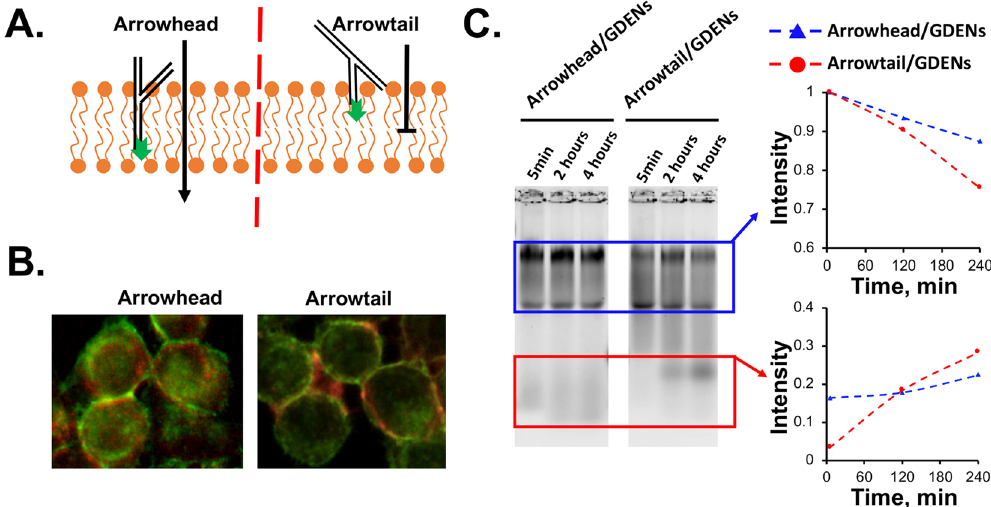
Figure 5. The interaction of arrowtail and arrowhead-displaying GDENs with cells. ( A ) Concept of ligand displaying by arrowtail and partially loading by arrowhead cause by different orientation. ( B ) Alexa 647 labeled arrowtail and arrowhead RNA nanoparticle (red) incubate with KB cell (green) and image by fluorescent microscopy as model to show surface displaying and loading. ( C ) Serum digestion assay indicate partially loaded arrowhead RNA nanoparticle exhibit more resistant than surface displaying arrowtail RNA nanoparticle. Band intensity were quantified by ImageJ and standardized by 5 min digestion sample.